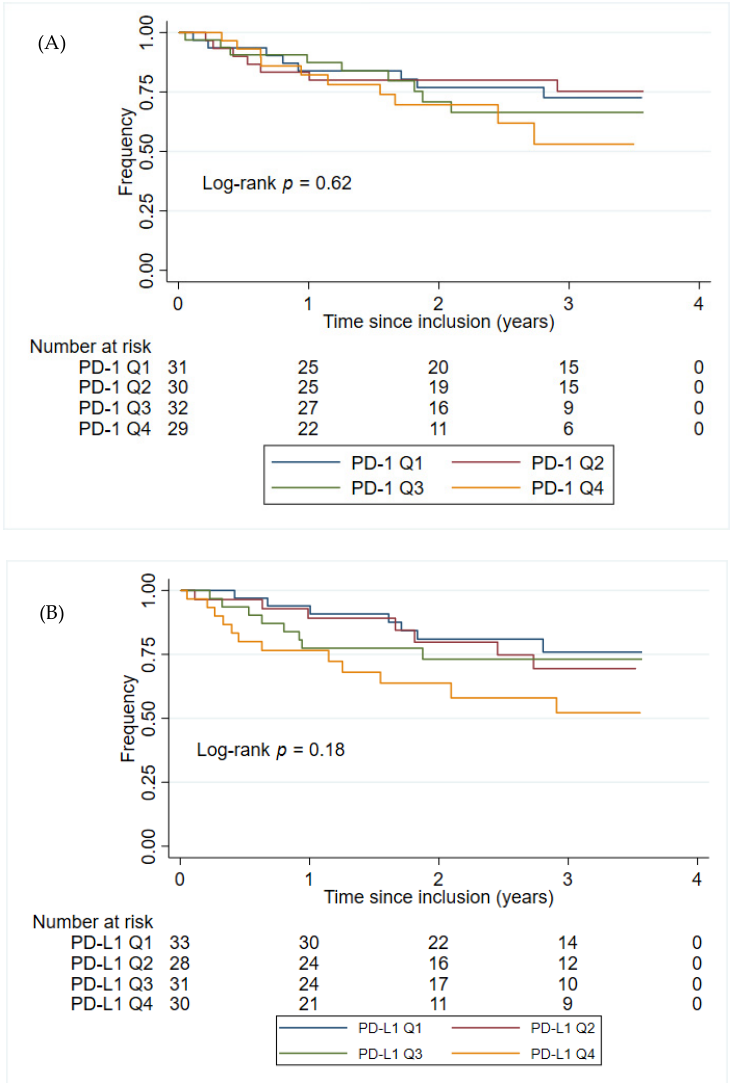
Figure 3. Kaplan–Meier plots for PFS from the time for inclusion of patients in group 2. ( A ) The patients in group 2 were stratified into four groups (Q1–Q4) based on the PD-1 concentration in group 2. PD-1 Q1: ≤ 162 pg/mL; PD-1 Q2: >162 pg/mL, ≤ 202 pg/mL; PD-1 Q3: >202 pg/mL, ≤ 258 pg/mL; PD-1 Q4: >258 pg/mL. ( B ) The patients in group 2 were stratified into four groups (Q1–Q4) based on the PD-L1 concentration in group 2. PD-L1 Q1: 149 pg/mL; PD-L1 Q2: >149 pg/mL, ≤ 179 pg/mL; PD-L1 Q3: >179 pg/mL, ≤ 225 pg/mL; PD-L1 Q4: >225 pg/mL. Abbreviations: PD-1: Programmed death protein-1; PD-L1: Programmed Death-Ligand 1.